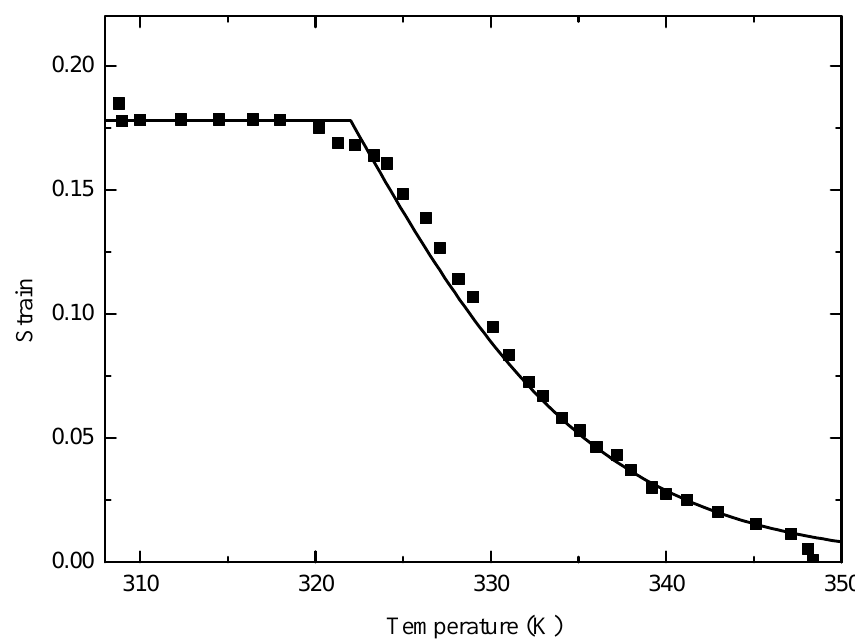
Figure 3. Fitting the data in [26] for the strain recovery effect of a SMP